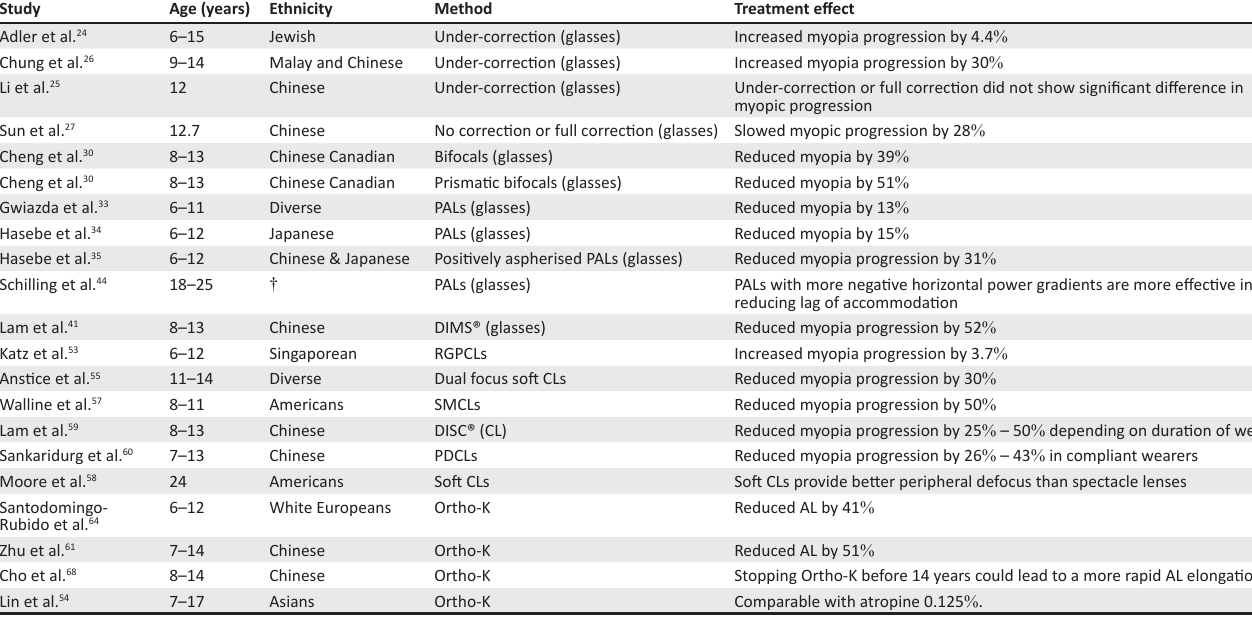
TABLE 2: Effect of optical methods on myopia progression.